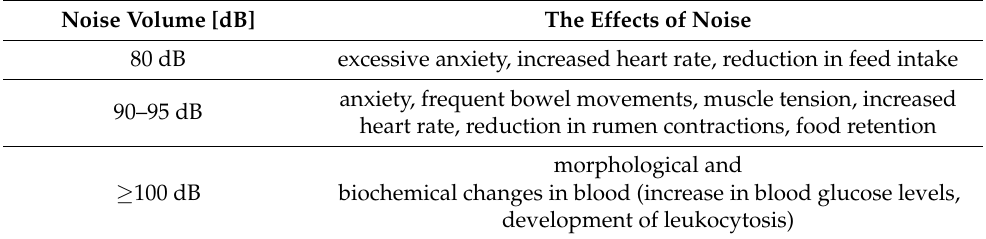
Table 1. Impact of noise of varying intensity on cattle. Own elaboration based on [59]. Noise Volume [dB] The Effects of Noise 80 dB excessive anxiety, increased heart rate, reduction in feed intake anxiety, frequent bowel movements, muscle tension, increased 90–95 dB heart rate, reduction in rumen contractions, food retention morphological and ≥ 100 dB biochemical changes in blood (increase in blood glucose levels, development of